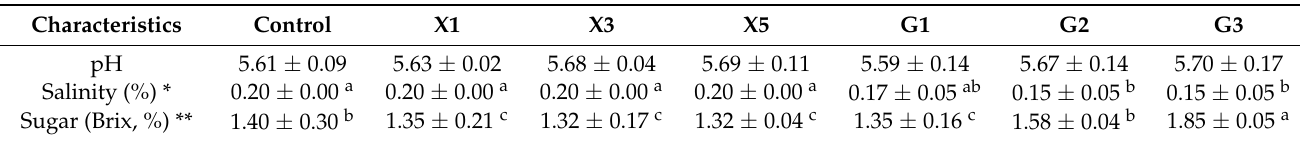
Table 3. Changes in pH, salinity, and sweetness of soymilk-based banana-blueberry-puree by adding thickeners XanFlax and brand G. Characteristics